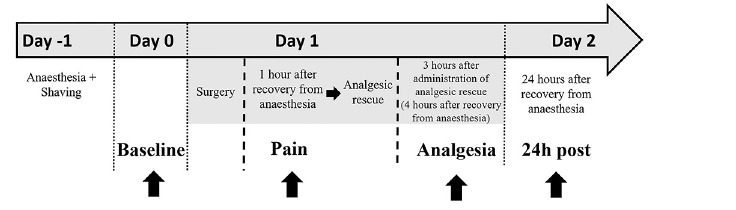
Fig 1. Timeline of procedures and video recordings.